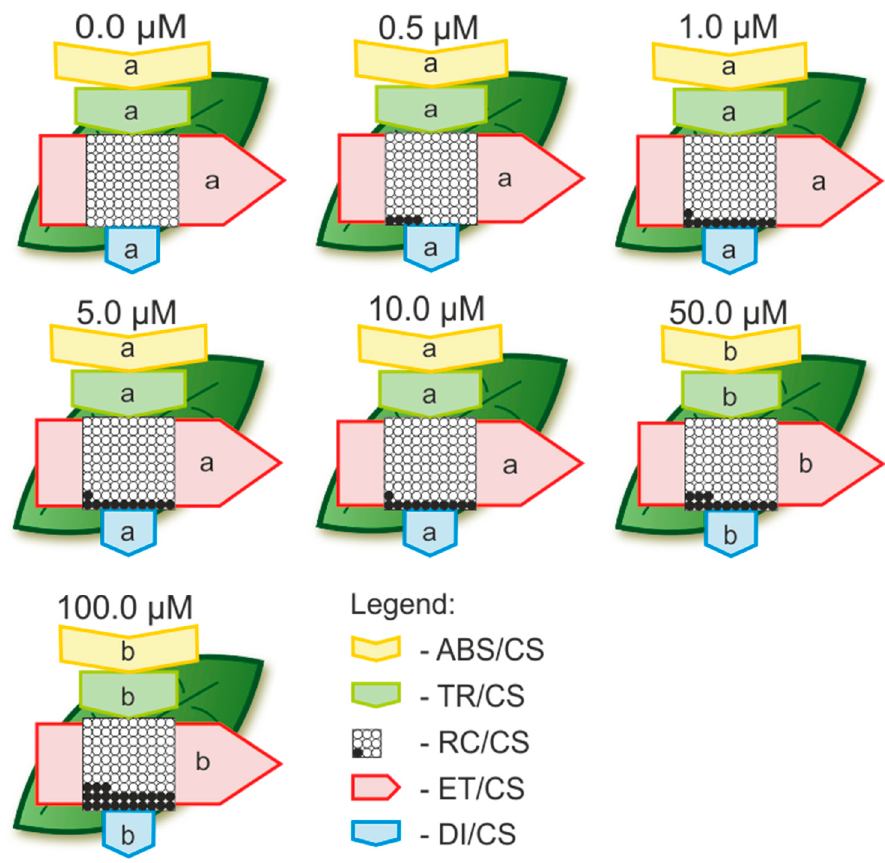
Figure 5. Leaf models showing the phenomenological the energy fluxes per excited cross sections (CS) of the corn leaves treated with different Pb concentrations. Each relative value is the mean ( n = 15) and is represented by the size of the correct parameters (arrows). Letters in the arrows correspond to the statistical significance (LSD test, p < 0.05). ABS/CS—absorption flux per CS approximated; TR/CS—trapped energy flux per CS; ET/CS—electron transport flux per CS; RC/CS—% of active/inactive reaction centers as circles inscribed in the square (white = active, black = inactive); DI/CS—dissipated energy flux per CS.